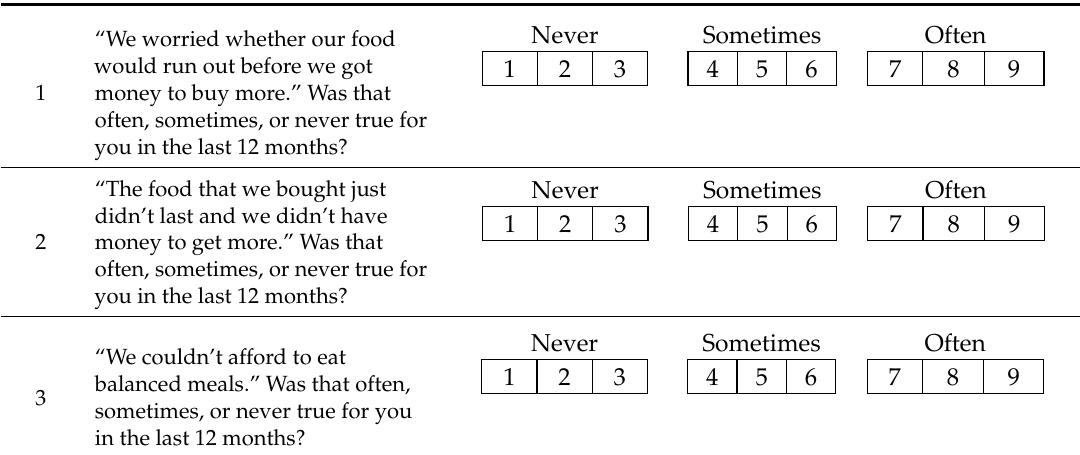
Table A1. 18-Question Core Food Security Module.